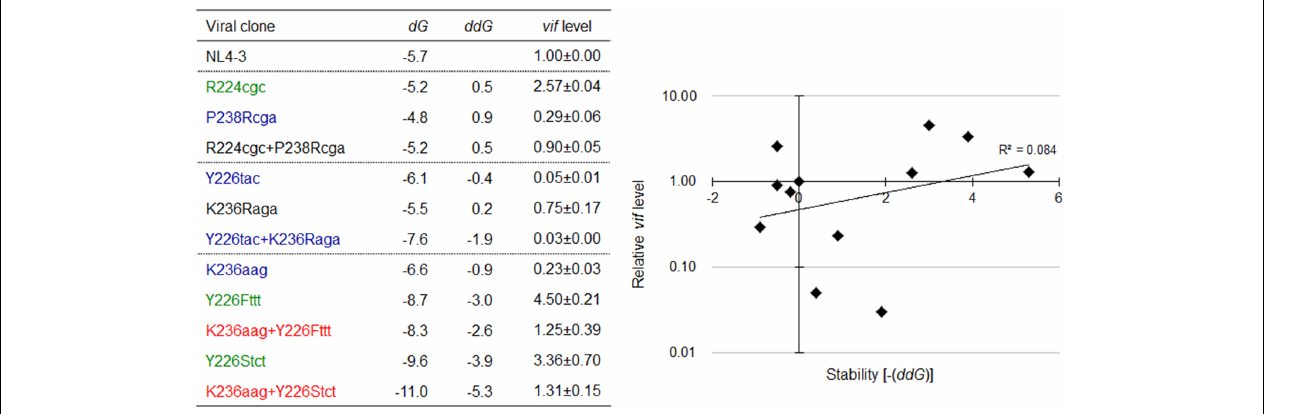
FIGURE 10 | Relationship between the vif expression level and SLSA1 RNA stability. SLSA1 variants in Figure 9 were analyzed for vif expressions and SLSA1 stabilities. Free energy ( d G) for each SLSA1 RNA is predicted by mfold program (Zuker, 2003). Stability ( dd G) of SLSA1 RNA structure is presented as difference of free energy between mutants and NL4-3. For determination of vif production level, proviral clones indicated were transfected into 293T cells, and total RNA was prepared from cells collected at 20 h post-transfection. DNase I-treated RNAs were used for cDNA synthesis with oligo (dT) primer, and resultant cDNA samples were subjected to qRT-PCR analysis using a specific primer set for vif mRNA. Expression levels of all HIV-1 mRNA species and GAPDH mRNA were analyzed by qRT-PCR in parallel for transfection and internal controls, respectively. A vif expression level in each sample was normalized by those of all HIV-1 mRNA species and GAPDH mRNA. Vif expression levels relative to those by NL4-3 are presented. Mean values ± SD from three independent experiments are shown. Scatter diagram on the right was created by plotting vif expression levels and SLSA1 stabilities [–( dd G)] of the test clones relative to those of NL4-3. Exponential trendline and coefficient of determination ( R 2 = 0.084, p = 0.161 by F -test) are shown. Blue, red, and green letters indicate low, high, and excessive vif types (Nomaguchi et al., 2016),